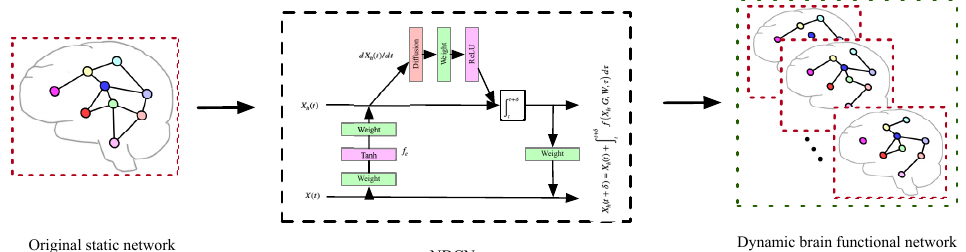
Figure 1. Overview of dynamic brain function network based on